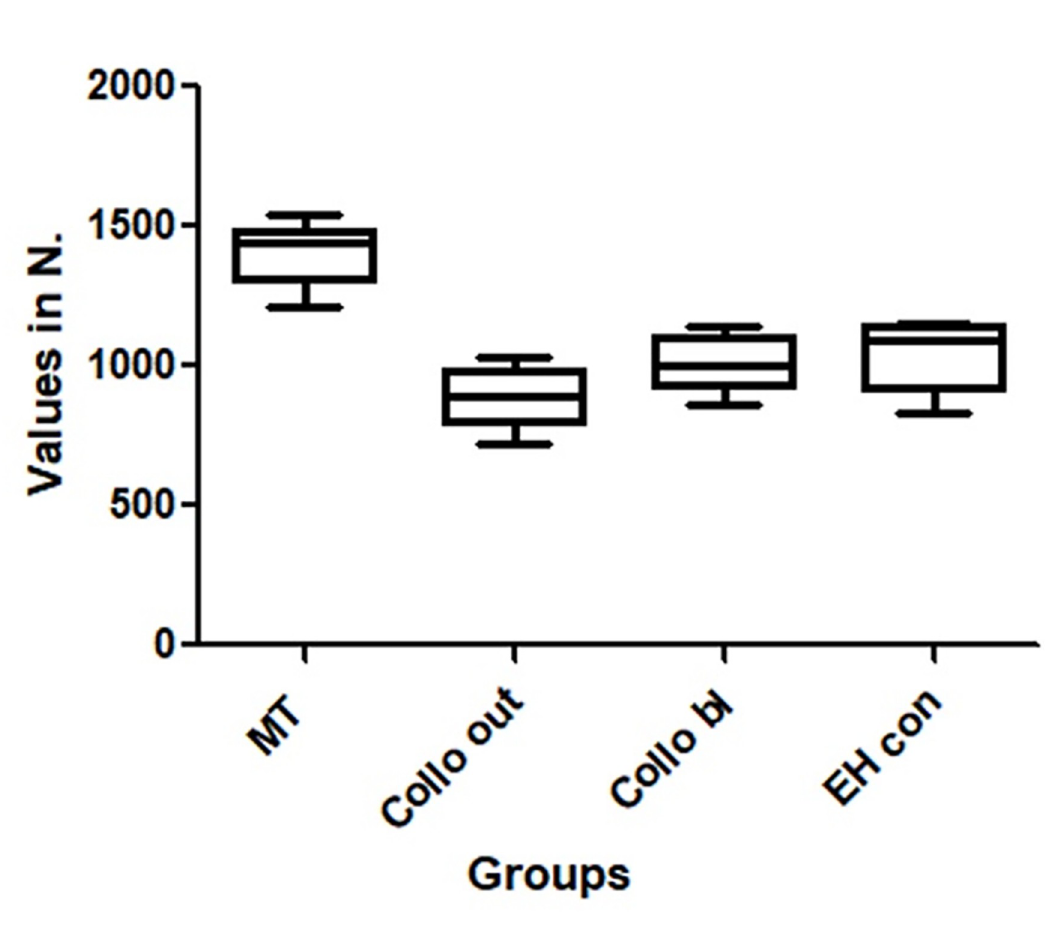
Fig 5. Image shows a box plot graph with the data distribution between the groups.